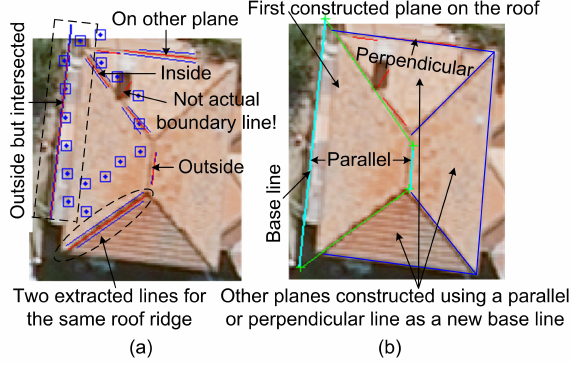
Figure 6: (a) Fitting image lines to an initial plane and (b) con- structed final planes.